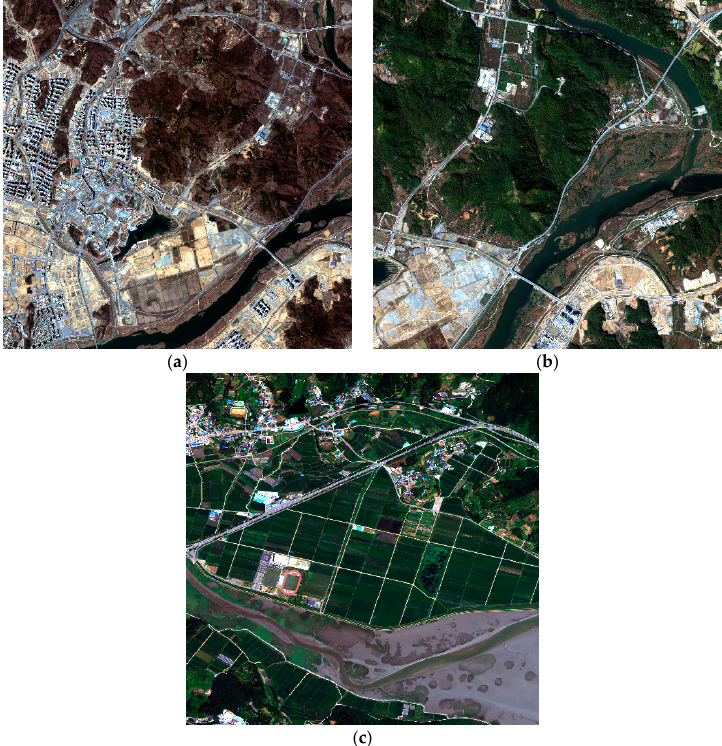
Figure 6. True-color composites of the test data: ( a ) KOMPSAT-3 imagery; ( b ) KOMPSAT-3A imagery; ( c ) WorldView-3 imagery. Table 2. Specifications of the satellite sensors and datasets used in this study. KOMPSAT, Korean Multi-Purpose Satellite.